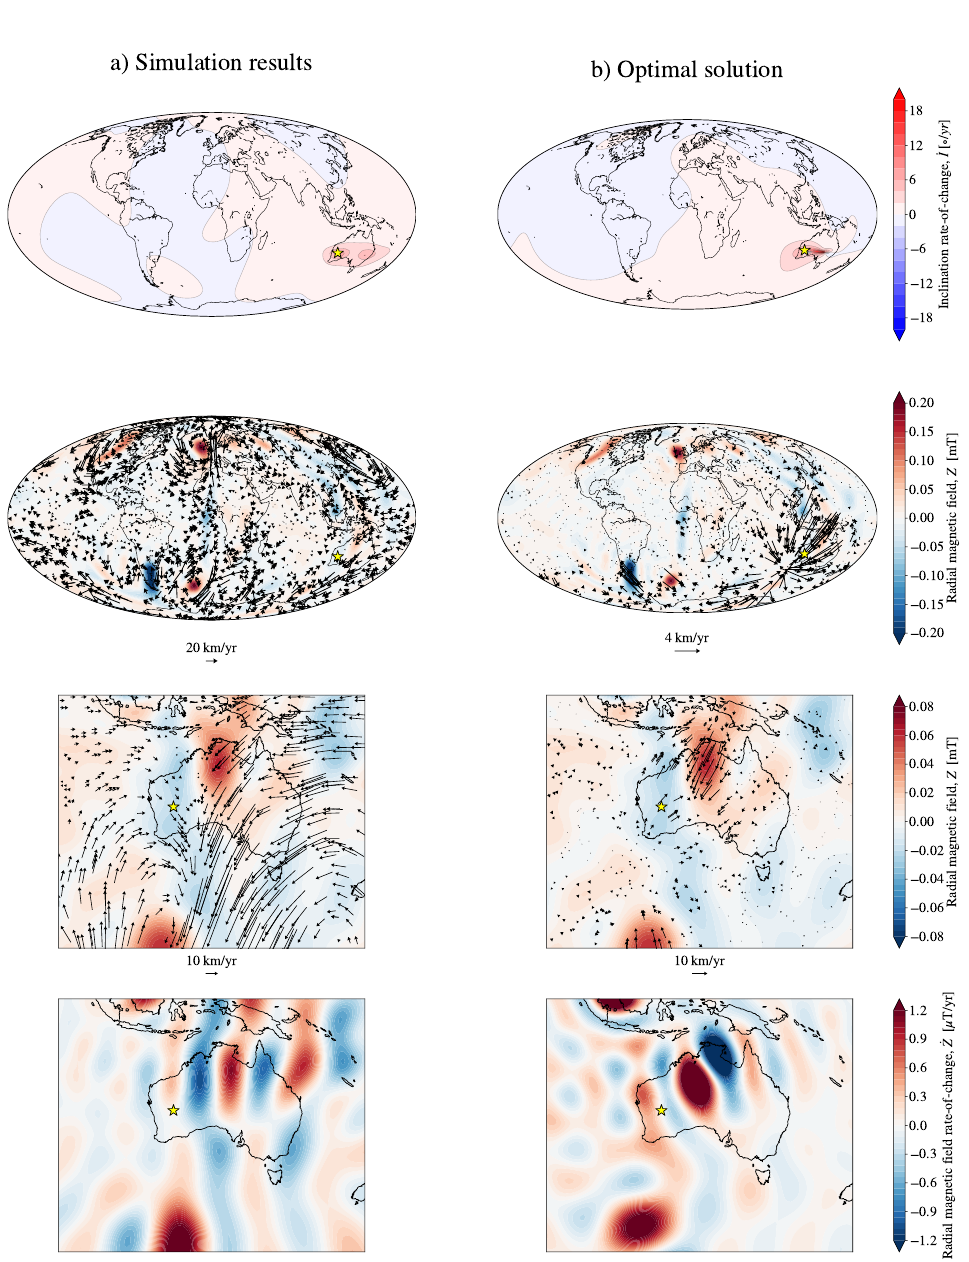
Figure 5. Numerical ( a ) and optimal ( b ) ˙ I calculations from the Rm = 450 geodynamo model from [26]. In all panels, the yellow star marks the location for which ˙ I is optimised, which is the same location in which extreme directional changes were observed in [26]. Top row: inclination rate of change from the Rm = 450 model output and optimal inclination rate of change, both evaluated at the surface of the Earth. Second row: map of the CMB radial magnetic field, Z = − B r (a choice made for ease of comparison with the figures in [26]), at the chosen epoch superimposed with ( a ) the horizontal flows at the horizontal flow boundary layer (see the main text, Section 4.1) and ( b ) the optimal flow. Third row: the same as the second row, but zoomed-in on the geographical location around the yellow star. Bottom row: secular variation (SV) from the numerical integration ( a ) and for the optimal solution ( b ), in the vicinity of the optimisation